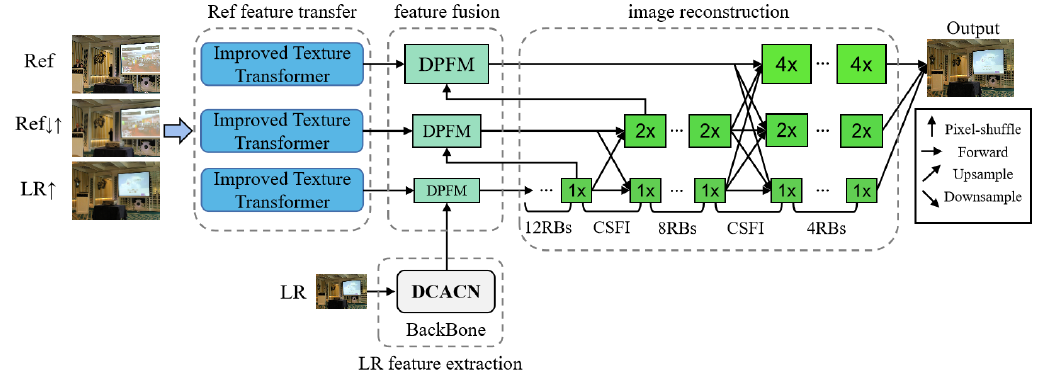
Figure 1. The overall structure of the proposed dual projection fusion for reference-based image super-resolution